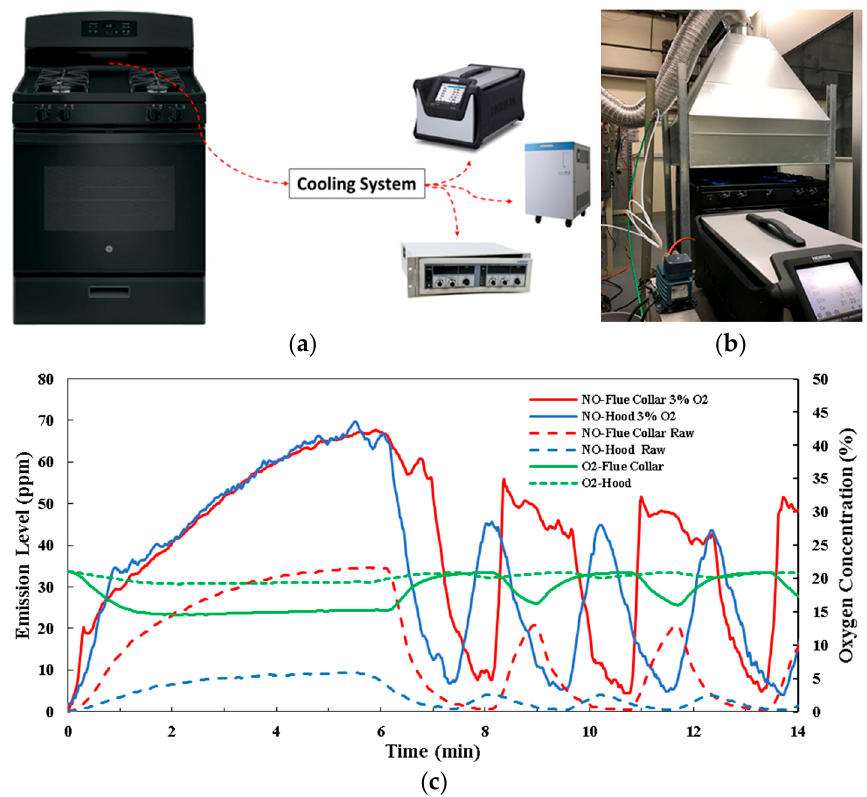
Figure 17. Validation of emission correction method using an oven burner [119]. ( a ) Flue collar sampling, ( b ) Exhaust hood sampling, ( c ) oven burner emission